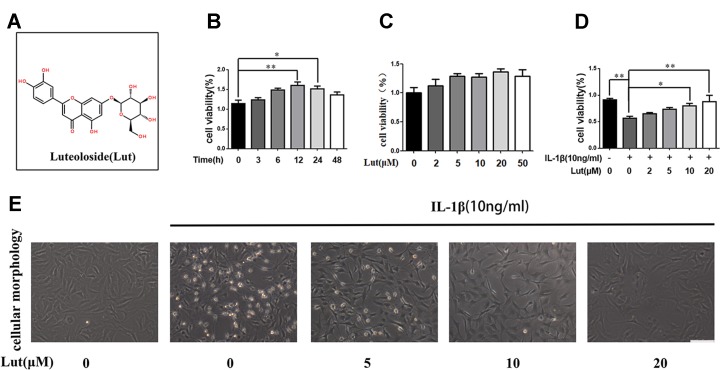
Effects of luteoloside on the cell viability of nucleus pulposus (NP) cells (A) Chemical structure of luteoloside. (B) The cytotoxic effect of 20 µM luteoloside on NP cells in a time-dependent manner using a Cell Counting Kit-8 (CCK-8) assay. (C) The cytotoxic effect of luteoloside on NP cells was determined at various concentrations for 24 h using a CCK-8 assay. (D) The cytotoxic effect of luteoloside on NP cells was determined at various concentrations with interleukin 1 beta (IL-1β) stimulation using a CCK-8 assay. (E) Morphological changes of NP cells treated with luteoloside in a dose dependent manner with IL-1β stimulation (original magnification × 200, scale bar: 50 µm). All experiments were performed at least three times, and the data in the figures represent the mean ± S.D. Significant differences between groups are indicated as **P < 0.01, *P < 0.05.